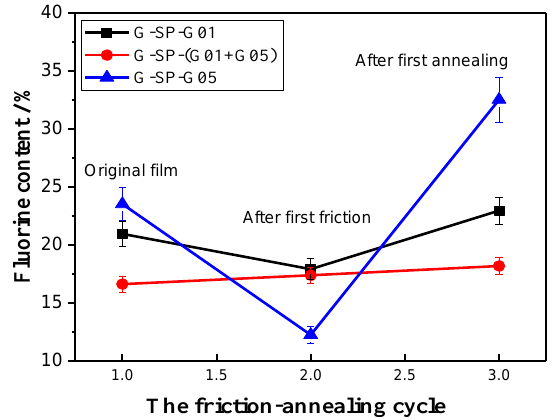
Figure 6. The change in fluorine content on the surface of the hybrid coatings during the first fric- friction-annealing tion-annealing cycle.